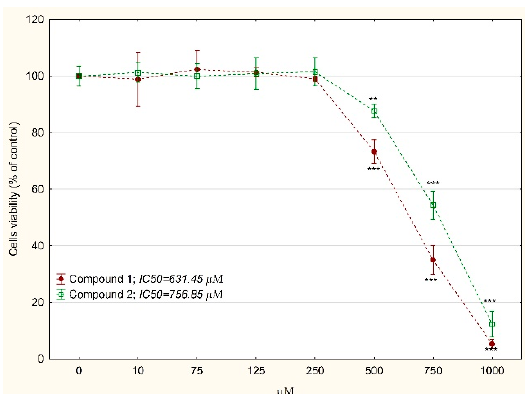
IC 50 value was determined using the AAT Bioquest IC 50 calculator.